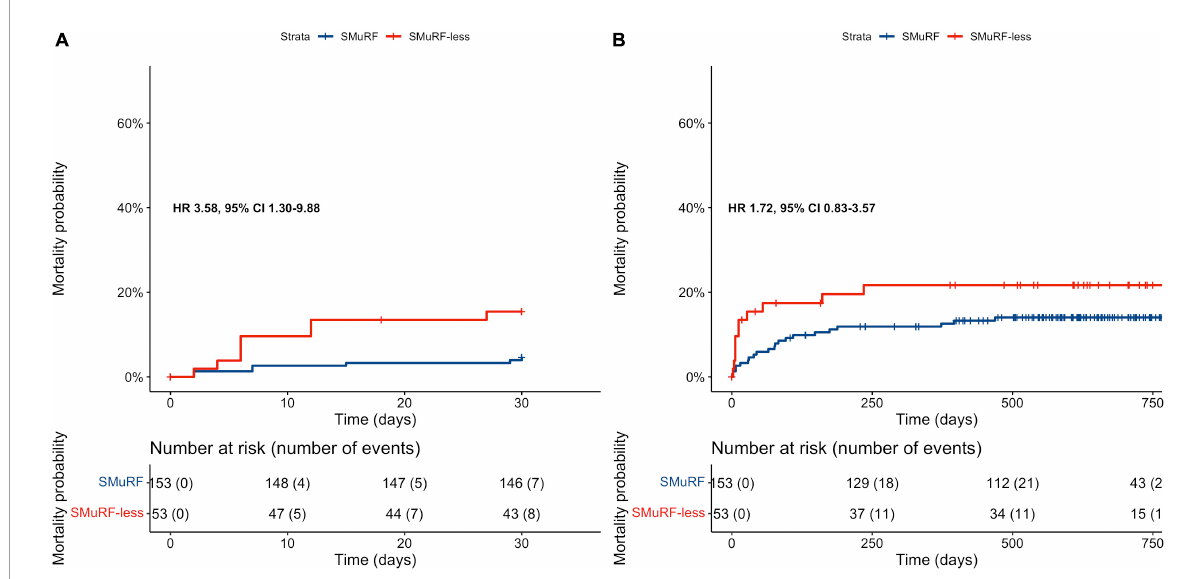
FIGURE2 Kaplan–Meier curves depending on the presence of SMuRFs for: (A) 30-day all-cause mortality rates, (B) long-term all-cause mortality rates. SMuRF-less patients had significantly higher incidence of 30-day all-cause mortality; however, long-term mortality rates did not differ significantly among patients with and without SMuRFs. Both survival analyses included 206/224 matched participants since follow-up data were not available for the remaining ones.